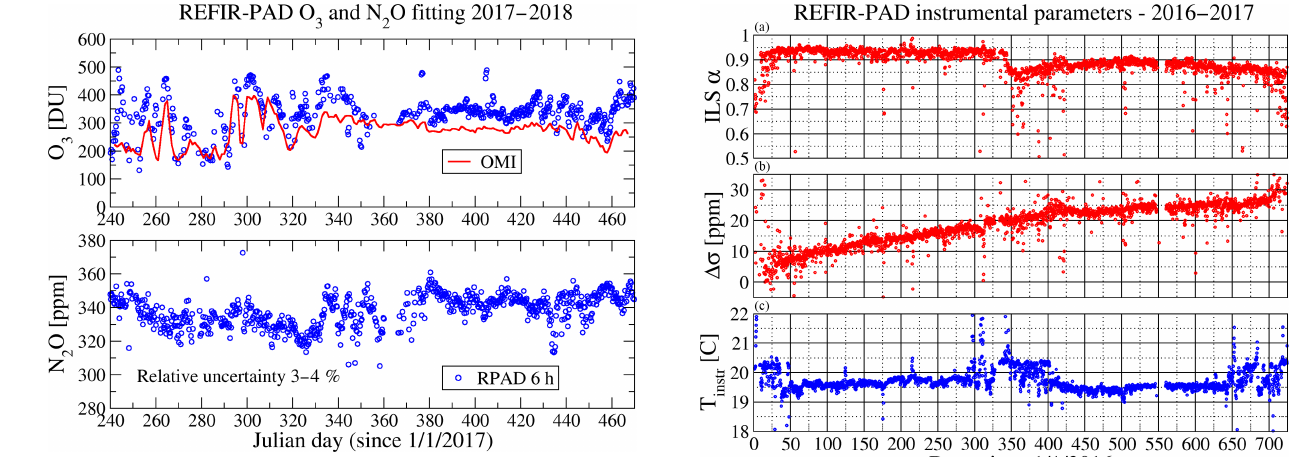
Figure 18. REFIR-PAD instrumental parameters for the 2016–2017 period. (a) ILS coefficient α . (b) Laser frequency error (cid:49)σ . (c) In- strument